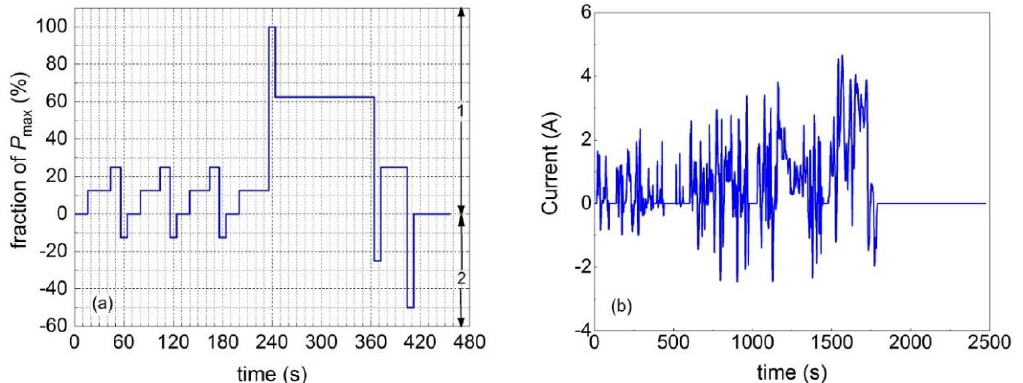
Figure 7. Estimated open circuit voltage.